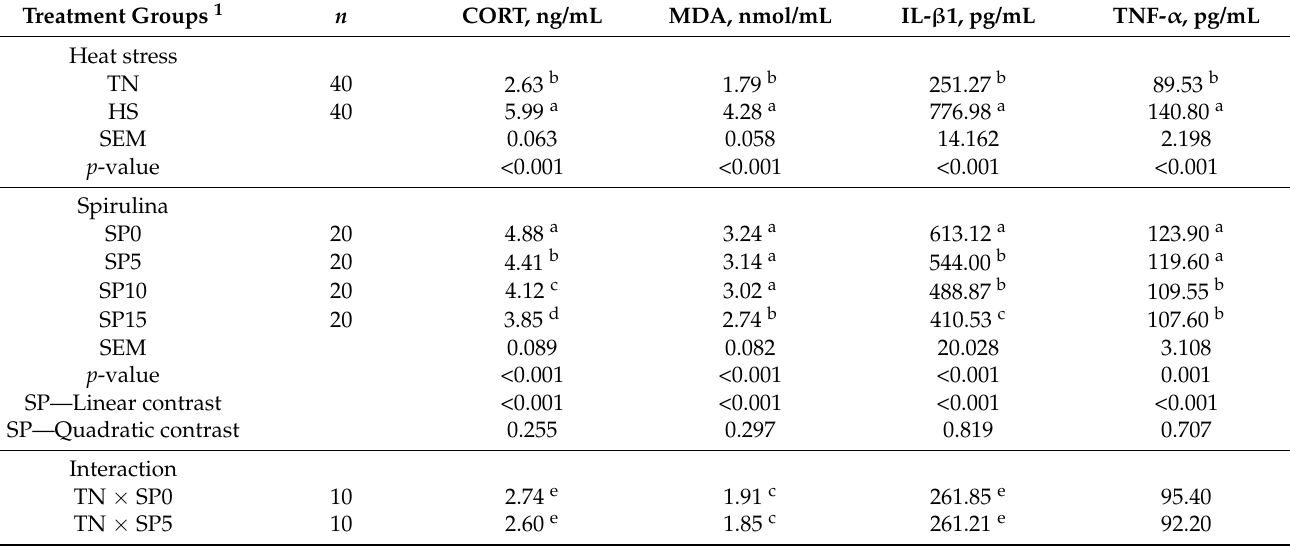
Table 6. Heat stress, spirulina, and their interaction effects on the stress measurements of Japanese quail